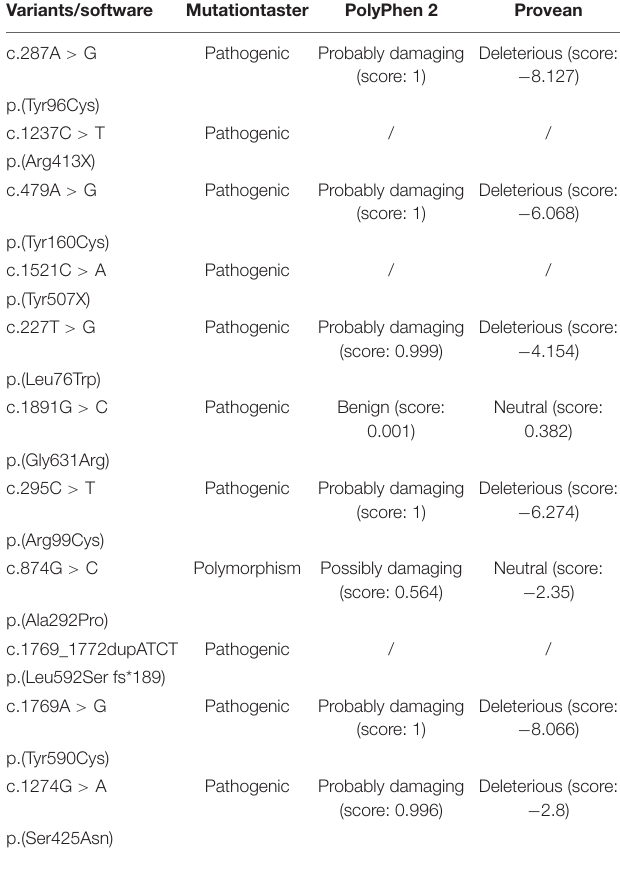
TABLE 2 | Pathogenicity prediction results of clinically unreported POMT2